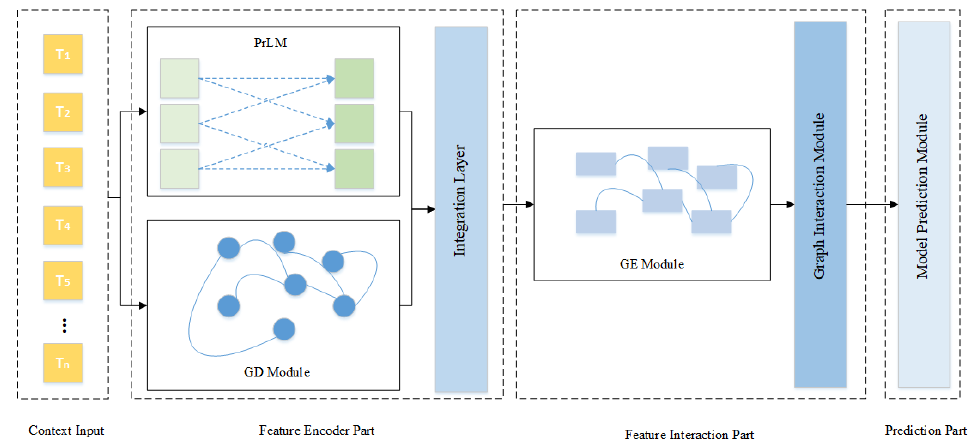
Figure 2. This is the overall structure of the model framework. The text is fed into the pretrained language model and our GD module (lower middle), respectively. In the GD module, a graph network is constructed according to the dependencies of the input text and fused with the output of pretrained language model. The GE module (middle right) extracts named entities in the text and builds a graph network and fuses it with BiDAF in the next layer. The model prediction module makes span